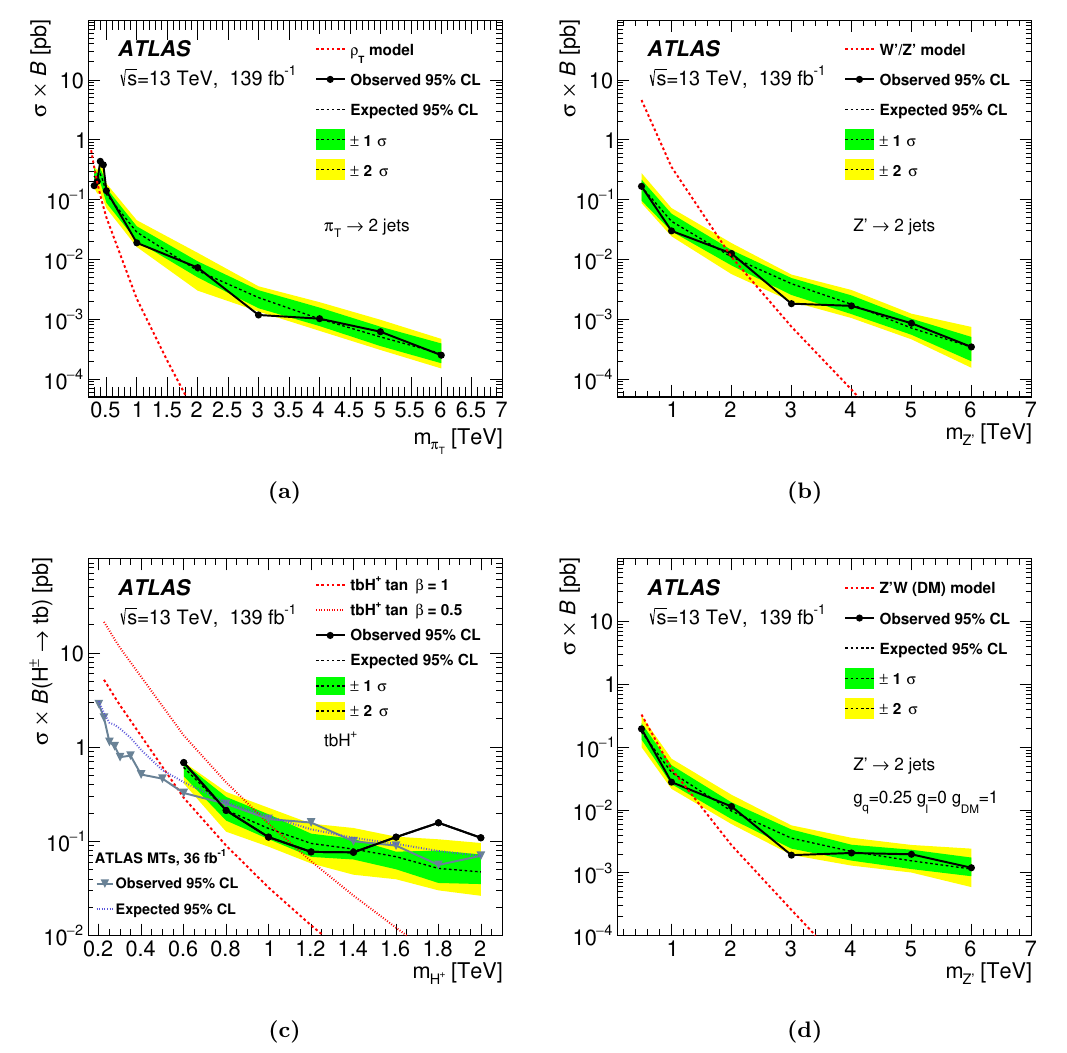
Figure 5. Observed ((cid:12)lled circles) and expected (dotted line with uncertainty bands) 95% credibility-level upper limits on the cross-section ( (cid:27) ) times branching ratio ( B ) for (a) the techicolor model with production of (cid:26) T decaying into (cid:25) T W (cid:6) , (b) W 0 Z 0 W (cid:6) production in the Sequential ! Standard Model, (c) the tbH + model for tan (cid:12) = 1 (thick red dashed line) and tan (cid:12) = 0 : 5 (thin red dashed line), (d) the simpli(cid:12)ed dark-matter model. Figure (c) also shows the expected and observed limits (without indicating the 1 and 2 (cid:27) bands) from the early Run 2 paper [68] based on the multivariate techniques (MTs) in the signal regions to enhance the separation of signal from background. The presented limits are obtained using two leading jets in events with at least one isolated lepton with p ‘ > 60 T